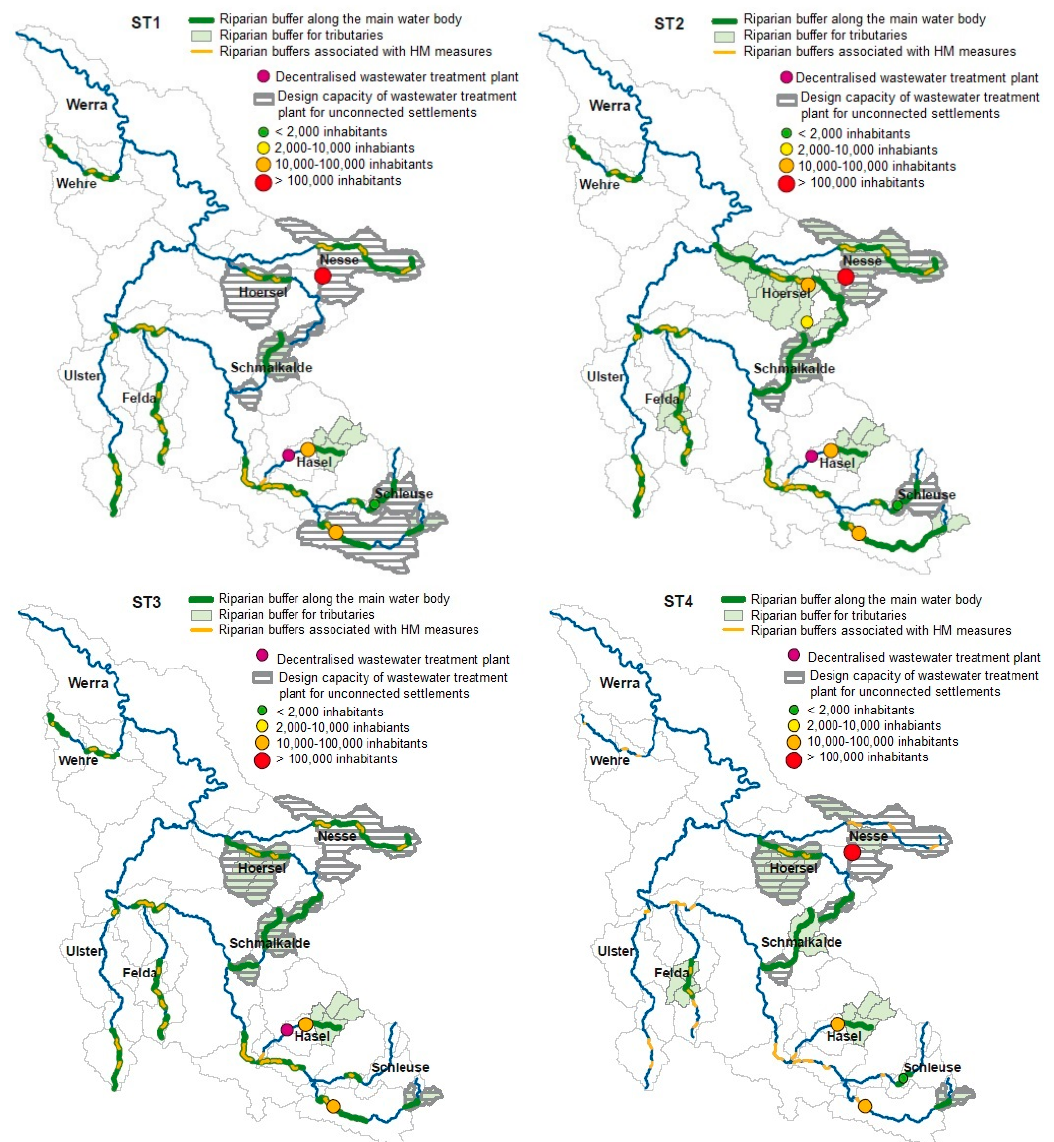
Figure 2. Summary of the proposed decision alternatives for the Integrated River Basin Management for the Werra River (IRBM-W) combining four emission strategies with two cost coverage scenarios.